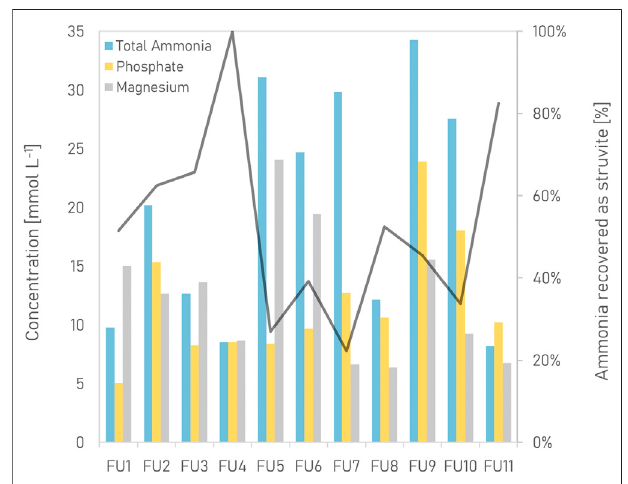
FIGURE 9 | Concentration of total ammonia and soluble phosphate in freshlyexcretedurineandconcentrationoftotalmagnesiuminfreshurinesaturated with Mg(OH) 2 at 25 ° C is shown for different urine compositions. The fraction of ammonia nitrogen that can be recovered from saturated urine as struvite is shown on the secondary y -axis. See Table 1 for the urine